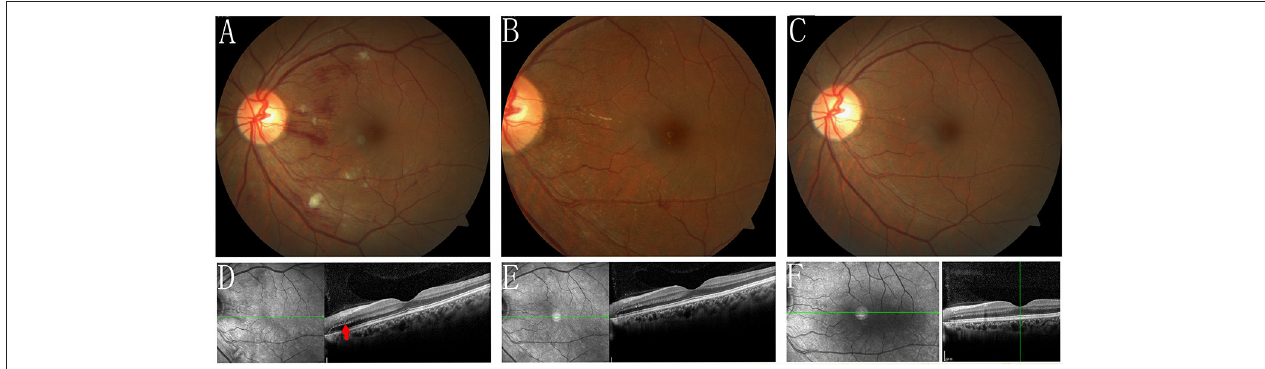
FIGURE 4 | Fundus photograph, and SD-OCT of the left eye during the follow-up. (A,D) 1 week follow-up, the IRF (red arrow) and SRD were reduced remarkably. (B,E) 1 month follow-up showed that the IRF and SRD were completely resolved. (C,F) At the most recent follow-up, after 4 months, the fundus appeared basically